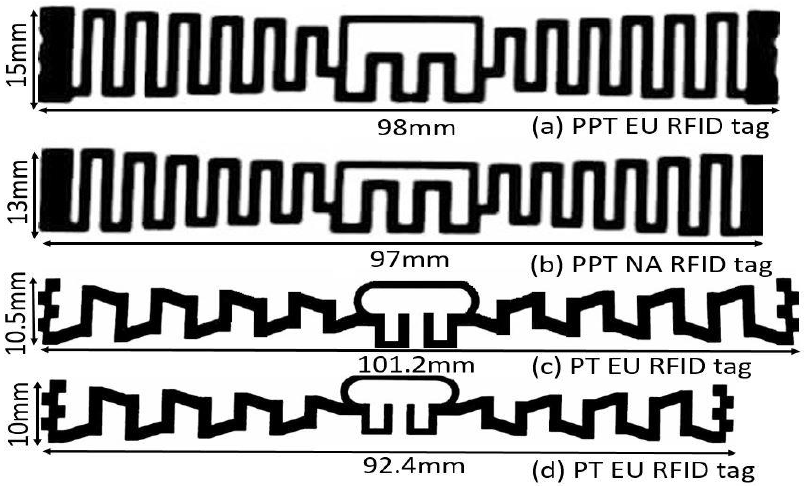
Figure 12. Prototypes of the antennas of previously published tags (PPT) and proposed tags (PT): ( a ) PPT EU UHF RFID tag (98 × 15 × 0.39 mm 3 ); ( b ) PPT NA UHF RFID tag (97 x 13 × 0.39 mm 3 ); ( c ) PT EU UHF RFID tag (101.2 × 10.5 × 0.39 mm 3 ); and ( d ) PT EU UHF RFID tag (92.4 × 10 × 0.39 mm 3 ).